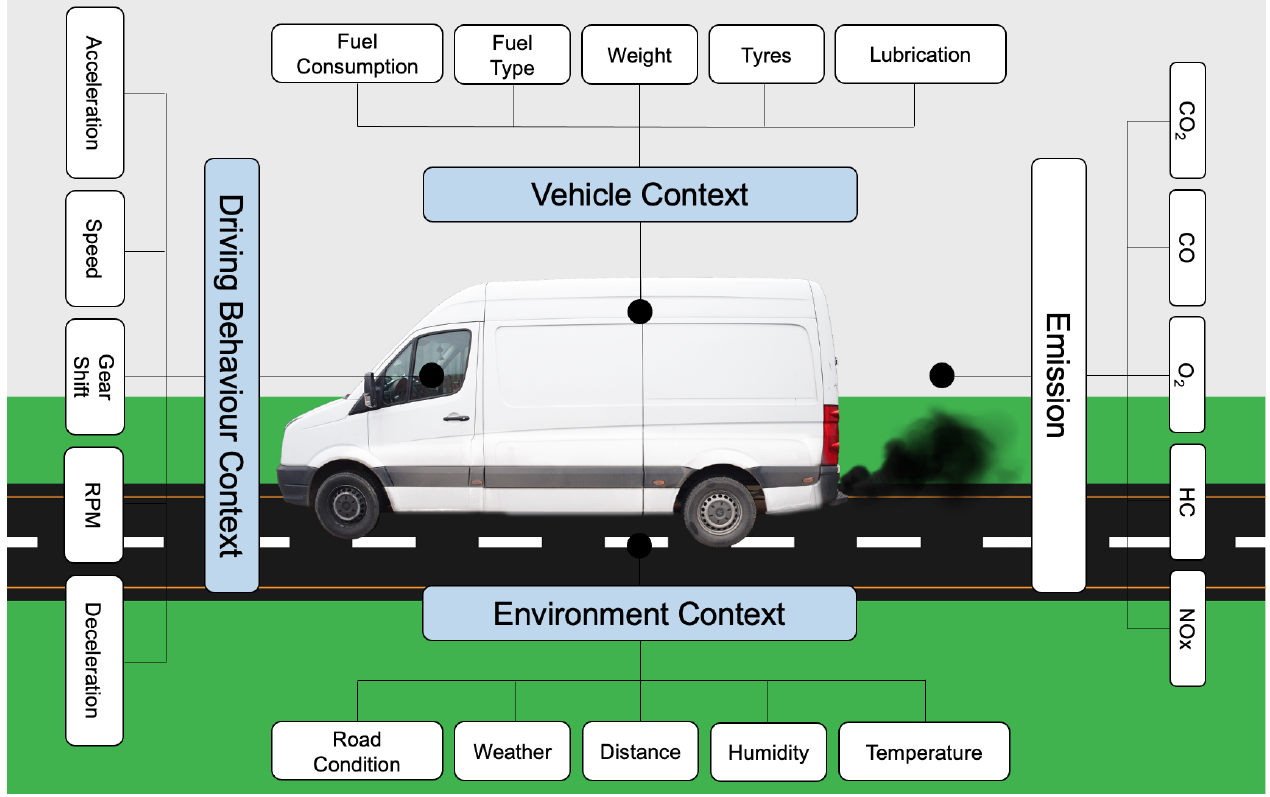
Figure 1. Emission impacting contexts and related